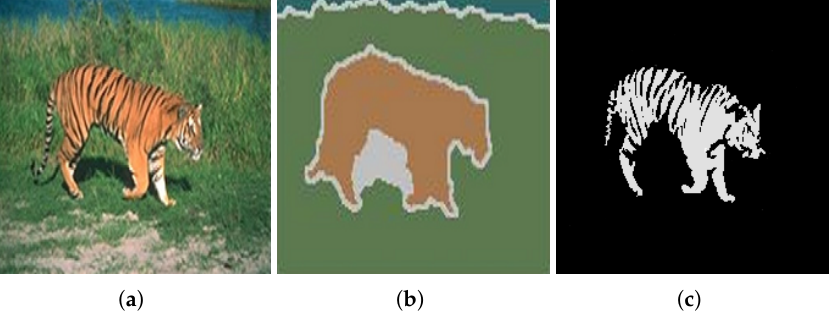
Figure 29. ( a ) Original image; ( b ) results obtained using the algorithm proposed by Carson et al. [104]; ( c ) results obtained using the algorithm proposed by the proposed approach. Images ( a , b ) referenced from Ilea and Whelan